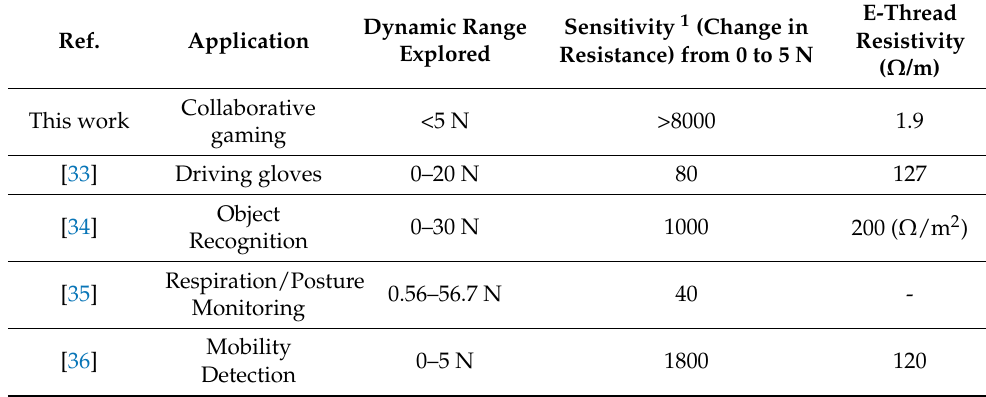
Table 1. Comparison of the reported solution compared to previously reported embroidered FSR.